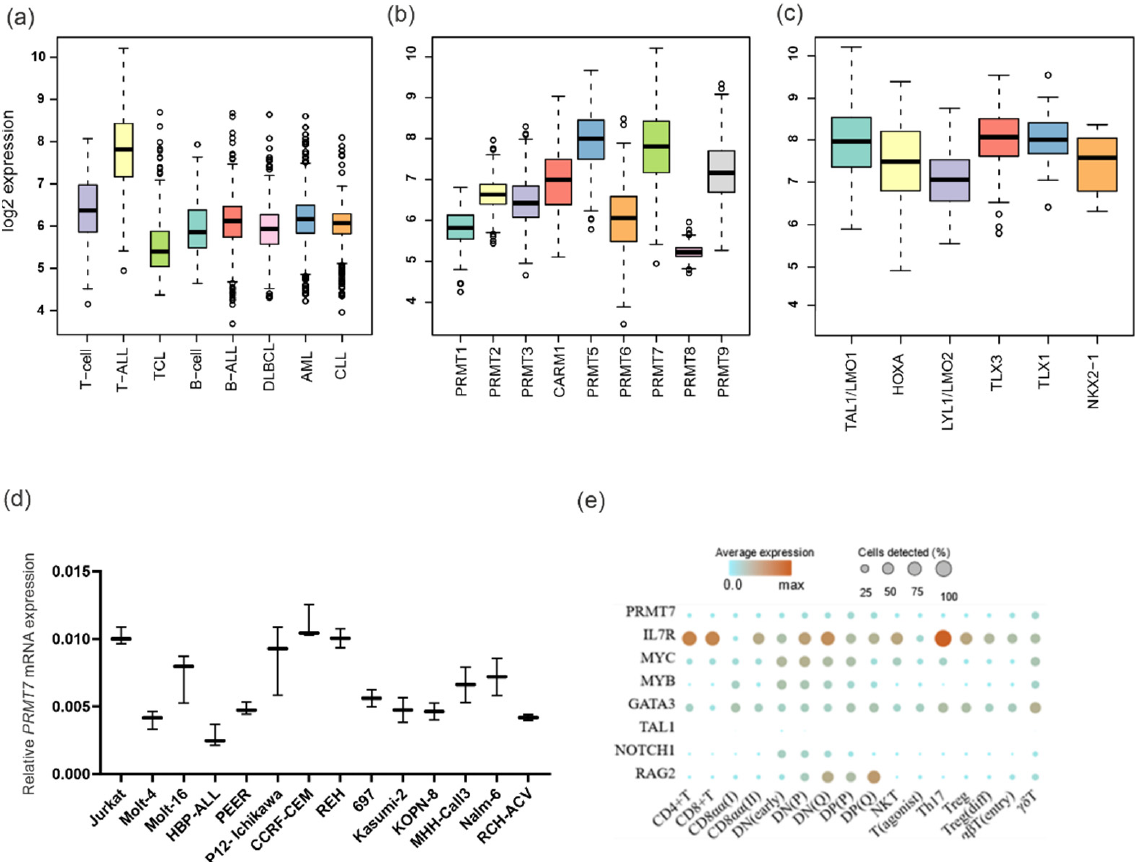
Figure 1. PRMT7 expression in hematological malignancies and healthy T-cells. ( a ) Expression of PRMT7 in leukemias ( n = 4430), lymphomas ( n = 1306), and healthy cells ( n = 428) in Hemap dataset ( p -values presented in Table S1); ( b ) summary of expression of all PRMT family genes in T-ALL; ( c ) expression of PRMT7 in subgroups of T-ALL ( HOXA vs. TAL1/LMO1 p = 0.003, HOXA vs. LYL1/LMO2 p = 0.026, HOXA vs. TLX3 p = 0.010, HOXA vs. TLX1 p = 0.006, HOXA vs. NKX2-1 p = 0.845, LYL1/LMO2 vs. HOXA p = 0.025, LYL1/LMO2 vs. TAL1/LMO1 p = 1.098 × 10 − 9 , LYL1/LMO2 vs. TLX3 p = 2.368 × 10 − 7 , LYL1/LMO2 vs. TLX1 p = 9.859 × 10 − 8 , and LYL1/LMO2 vs. NKX2-1 p = 0.198, TAL1/LMO2 n = 171, HOXA n = 56, LYL1/LMO2 n = 54, TLX3 n = 35 and NKX2-1 n = 11); ( d ) expression of PRMT7 mRNA in T- and B-ALL cell lines as measured by qRT-PCR ( n = 3).; and ( e ) expression of PRMT7 and the selected essential T-cell developmental genes during the T-cell differentiation and maturation process at single-cell resolution. Color indicates the mean expression and size the proportion of cells expressing the gene relative to the absolute number of cells detected in the dataset.